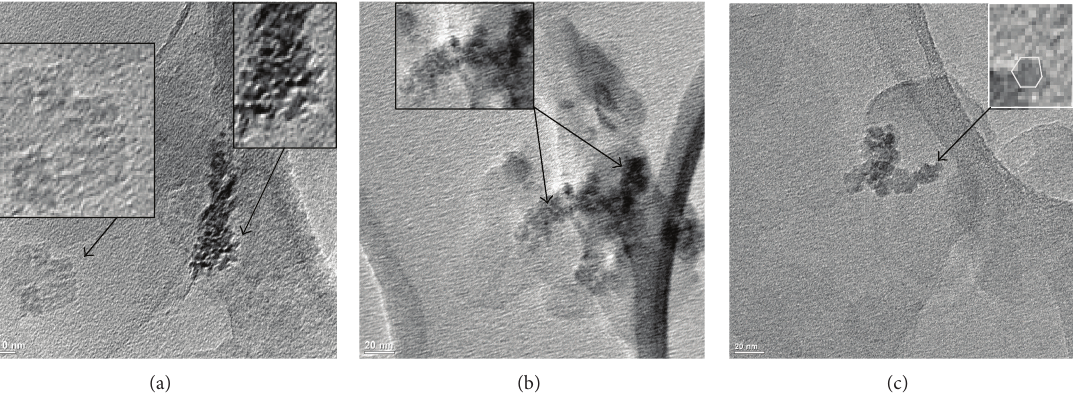
Figure 3: TEM images of the (a) montmorillonite nanocolloids showing some interlayering/disorder of the individual atoms, (b) mixed mineralogy nanocolloids showing some interlayering/disorder of the individual atoms, and (c) kaolinitic nanocolloids showing kaolinitic hexagonal